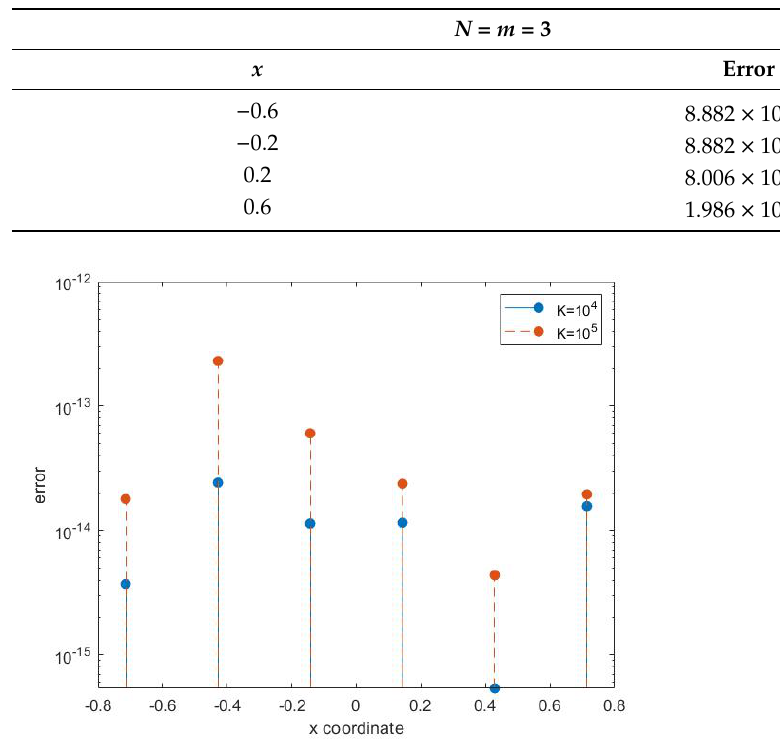
Figure 6. The absolute error for N = 5, m =